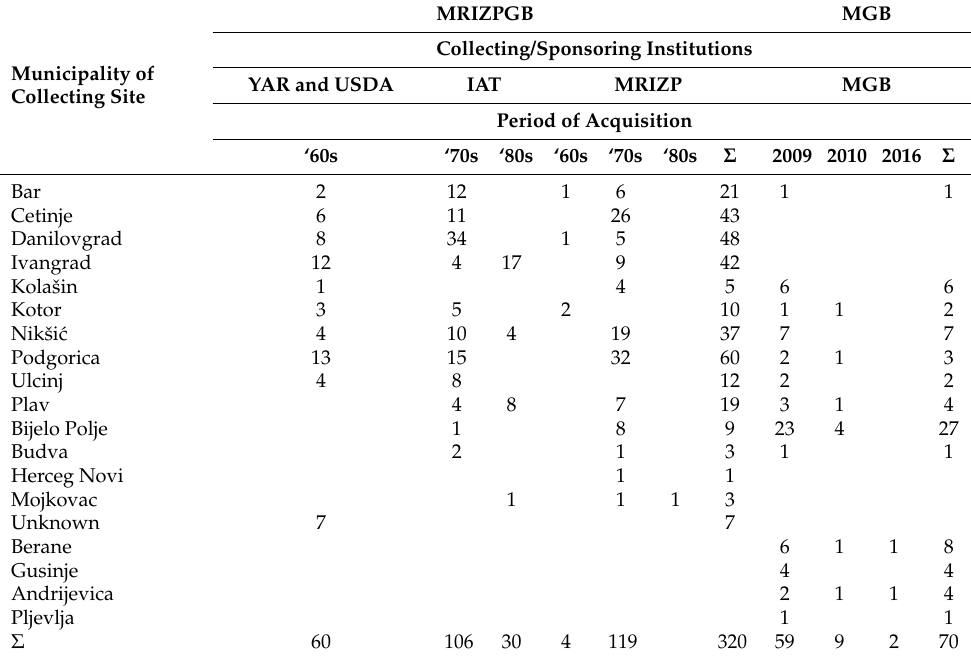
Table 1. Passport data of the MRIZPGB and MGB maize landraces collected in Montenegro.